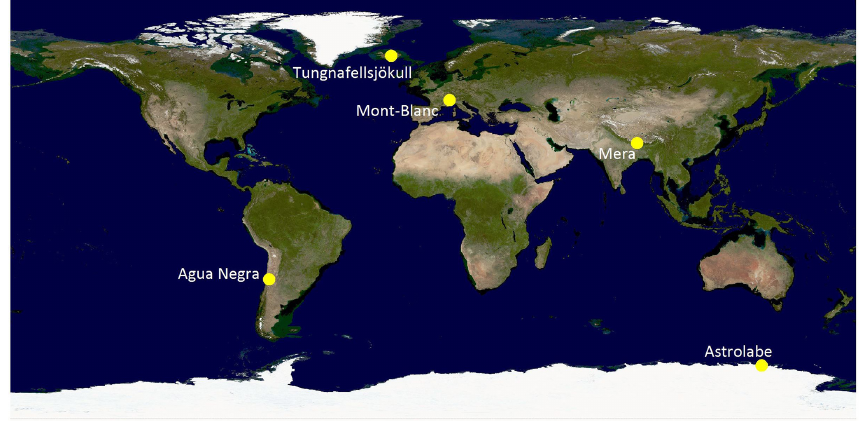
Figure 1. Study sites where Pléiades stereo pairs and tri-stereos were acquired. The background image is a MODIS mosaic from the Blue Marble Next Generation